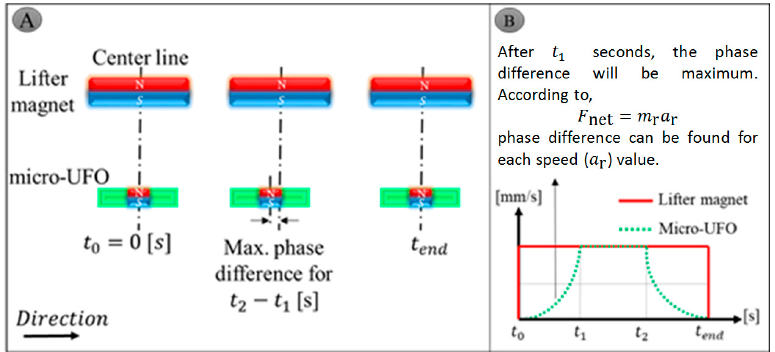
Figure 12. The phase difference between micro-UFO and lifter magnet starts from t 0 starting moment is shown in ( A ). After a period of time t 1 ( B ), the speed with the carrier magnet will be equal, and the phase difference reaching the maximum will begin to decrease after this point. Figure 6 and Table 2, micro-UFO acceleration, a r , can be calculated. For this micro-UFO and lifter magnet with velocity profile and acceleration specified, the difference phase difference can be expressed easily.